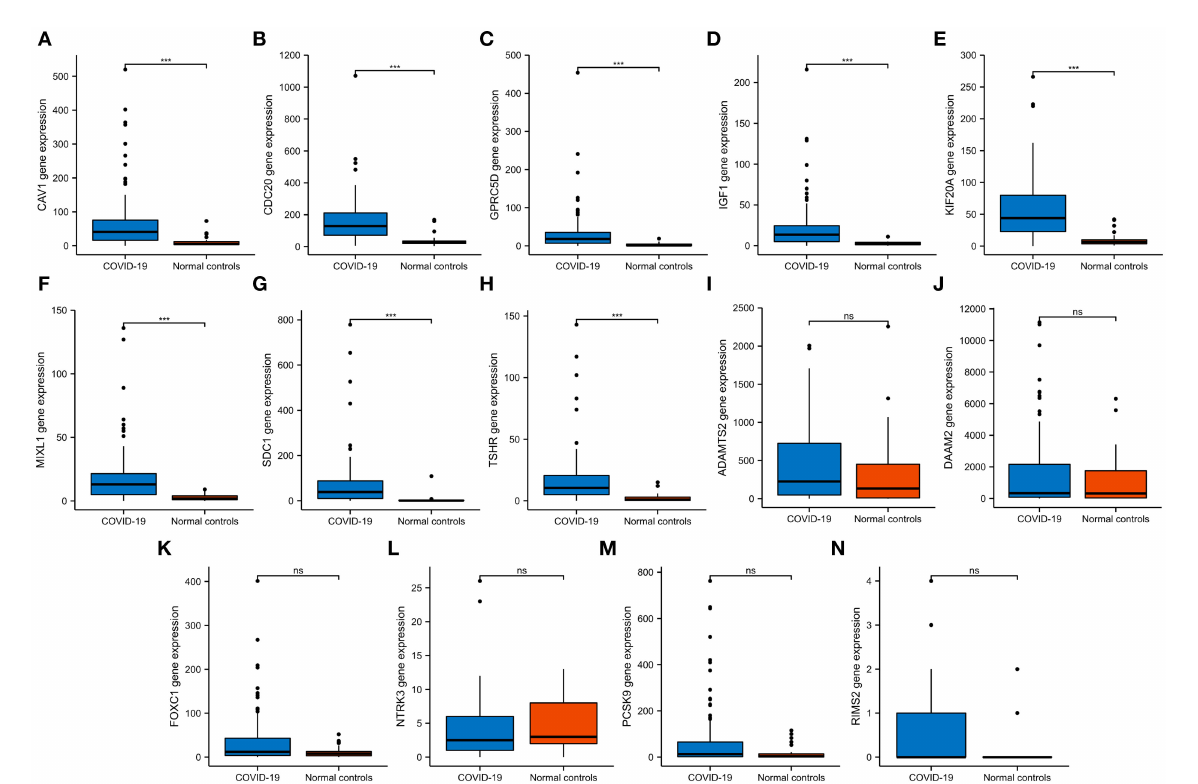
FIGURE6 The expression validation of 14 hub genes. (A–H) In the GSE157103 dataset, the expression of CAV1, CDC20, GPRC5D, IGF1, KIF20A, MIXL1, SDC1, and TSHR genes was significantly higher in COVID-19 whole blood leukocytes than in normal controls, which was consistent with the GSE152418 dataset. (I–N) In the GSE157103 dataset, the expression of ADAMTS2, DAAM2, FOXC1, NTRK3, PCSK9, and RIMS2 genes has no significant differences in whole blood leukocyte samples between COVID-19 patients and normal controls. NS, no significance; *** P < 0.001.